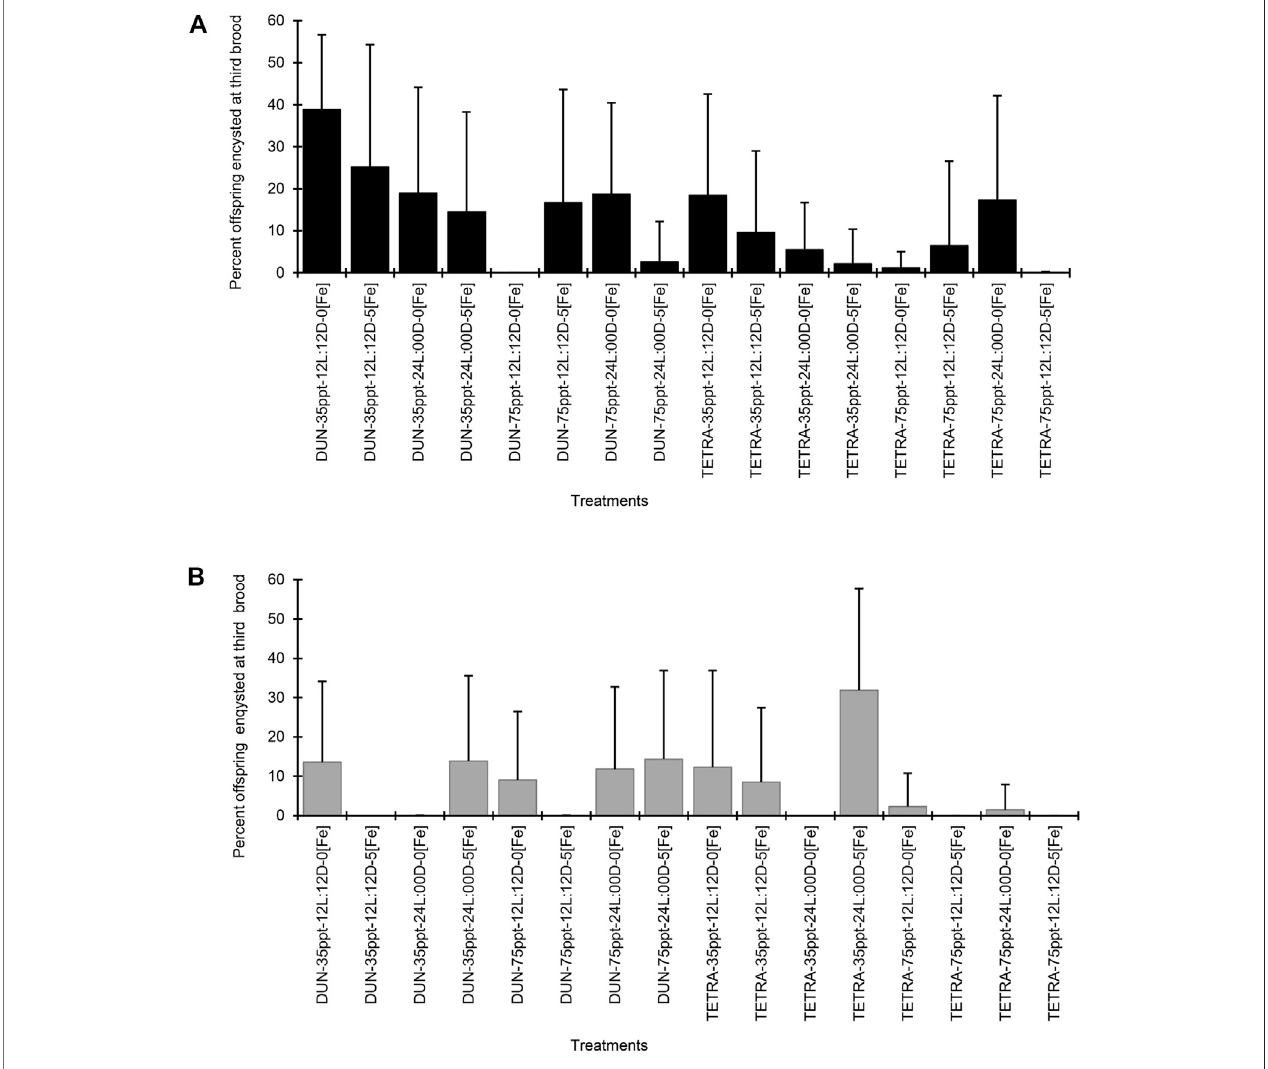
FIGURE 1 | Percent offspring encysted at third brood in two populations of Artemia franciscana exposed to a combination of different diets, salinities, photoperiods, and iron concentrations treatments. (A) Barro Negro population and (B) San Francisco Bay population. The error bars indicate one SD.